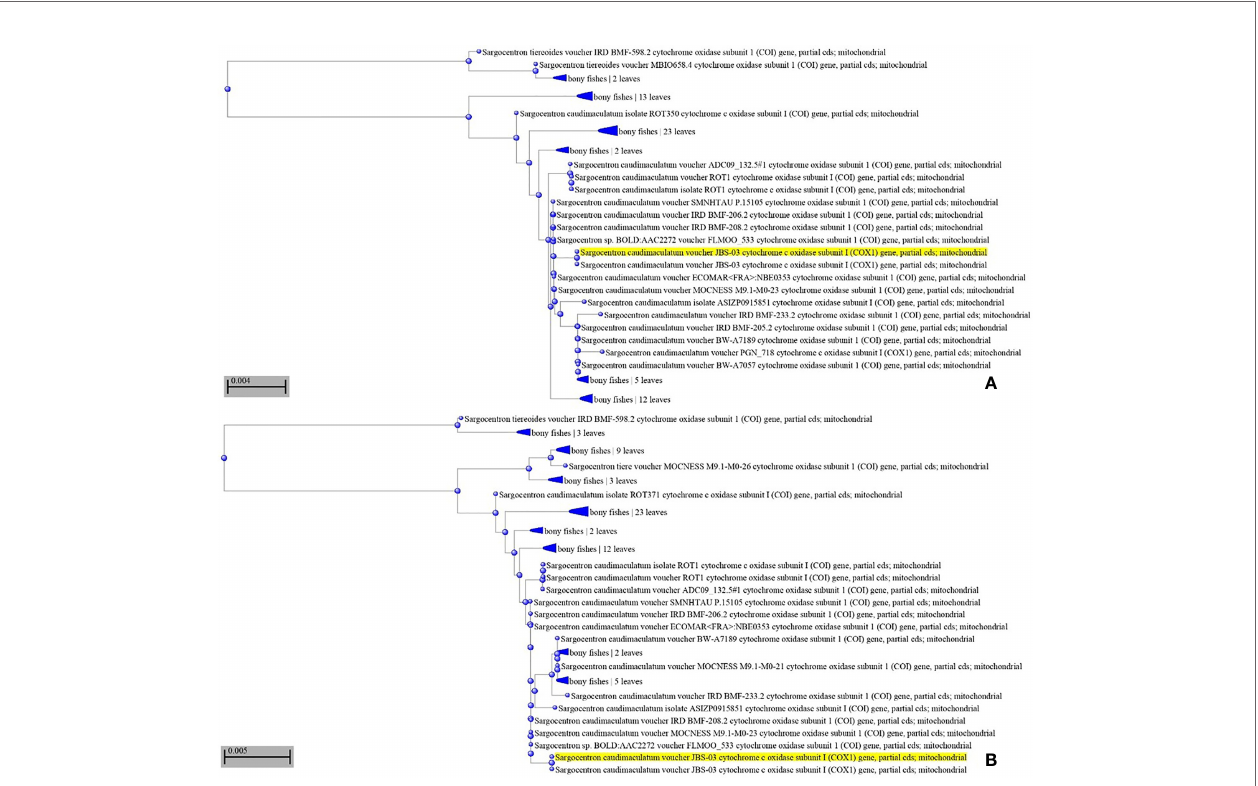
FIGURE 2 | Phylogenetic tree created with (A) , the neighbor joining method (NJ), (B) , The fast minimum evolution method by using Blast tree viewer to show the relationships between aligned cytochrome c oxidase subunit I (COI) gene partial sequence of S. caudimaculatum with comparison to Genbank